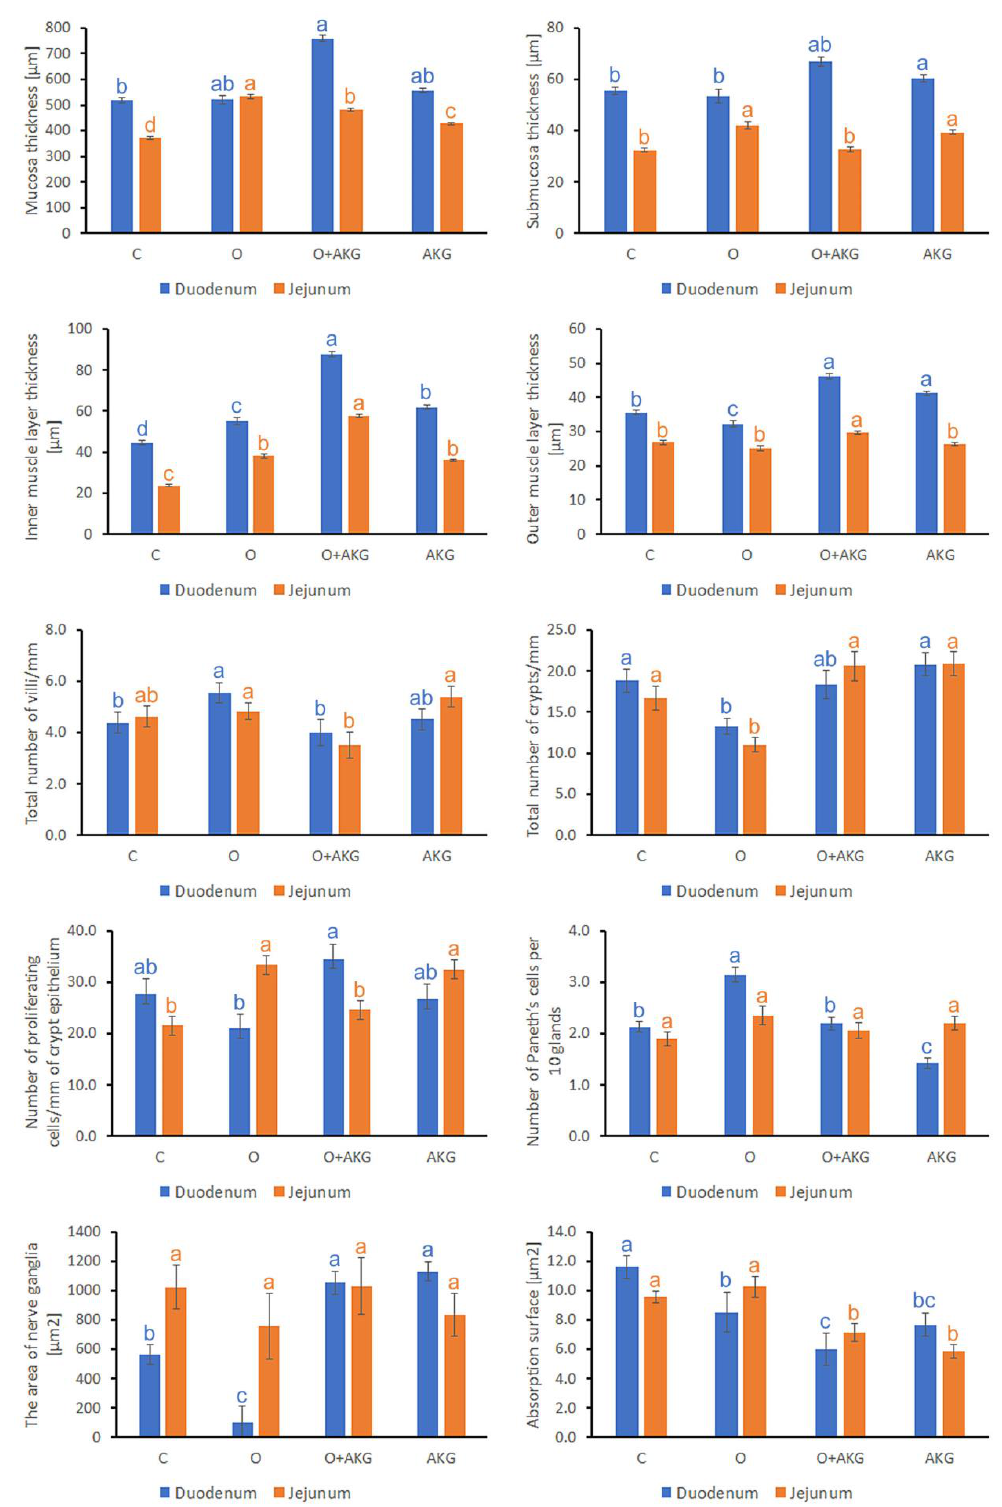
Figure 2. Effects of bariatric surgery and alpha-ketoglutarate (AKG) administration on selected structural parameters of the duodenum and jejunum in rats. C—control, O—gastric bypass surgery, O + AKG—gastric bypass surgery and administration of alpha-ketoglutarate, AKG—administration of alpha-ketoglutarate. Alpha-ketoglutarate (0.2 g/kg/body mass/day) was administered in the drinking water. Different letters above the bars indicate significant differences at p < 0.05, and colors are used to indicate the corresponding intestinal